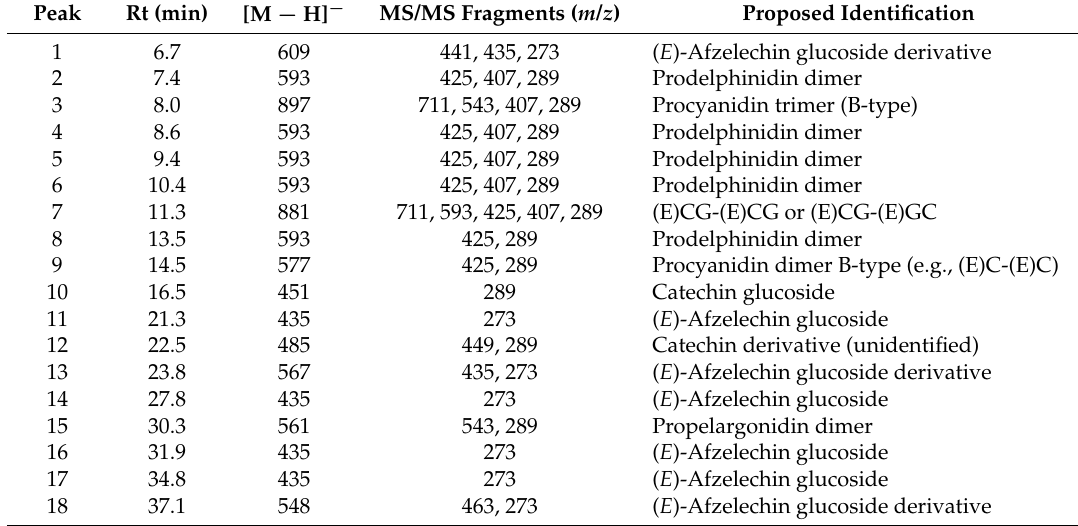
Table 1. TentativeidentificationofphenolicsinbananapassionfruitpulpsamplesbyHPLC-DAD-ESI/MS n .